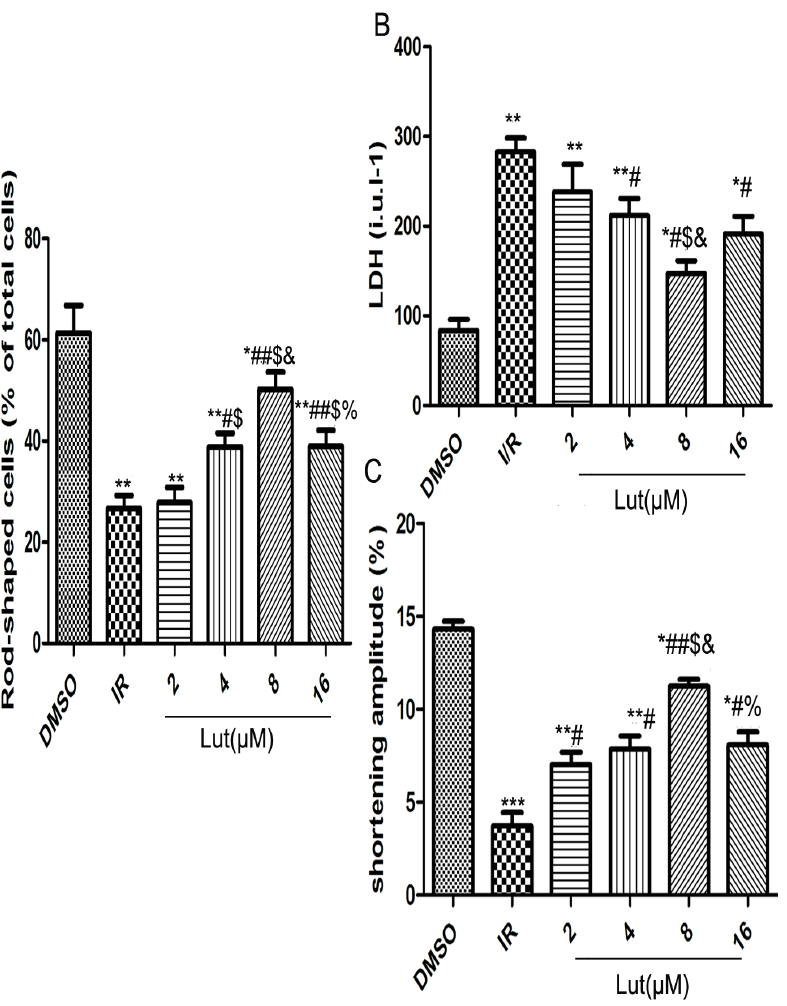
Figure 1. Grope the best concentrations of luteolin. Different concentration of luteolin on the number of rod-shaped cells(%) (A), Release of LDH (B) and cardiomyocyte shortening amplitude (C) after I/R were detected. Each value represents the mean 6 SEM, n= 6. * P , 0.05,** P , 0.01,*** P , 0.001 versus DMSO, # P , 0.05, ## P , 0.01 versus I/R. $ P , 0.05 versus Lut(2 m M) + I/R, & P , 0.05 versusu Lut(4 m M) + I/R, % P , 0.05 versusu Lut(8 m M) + I/R.